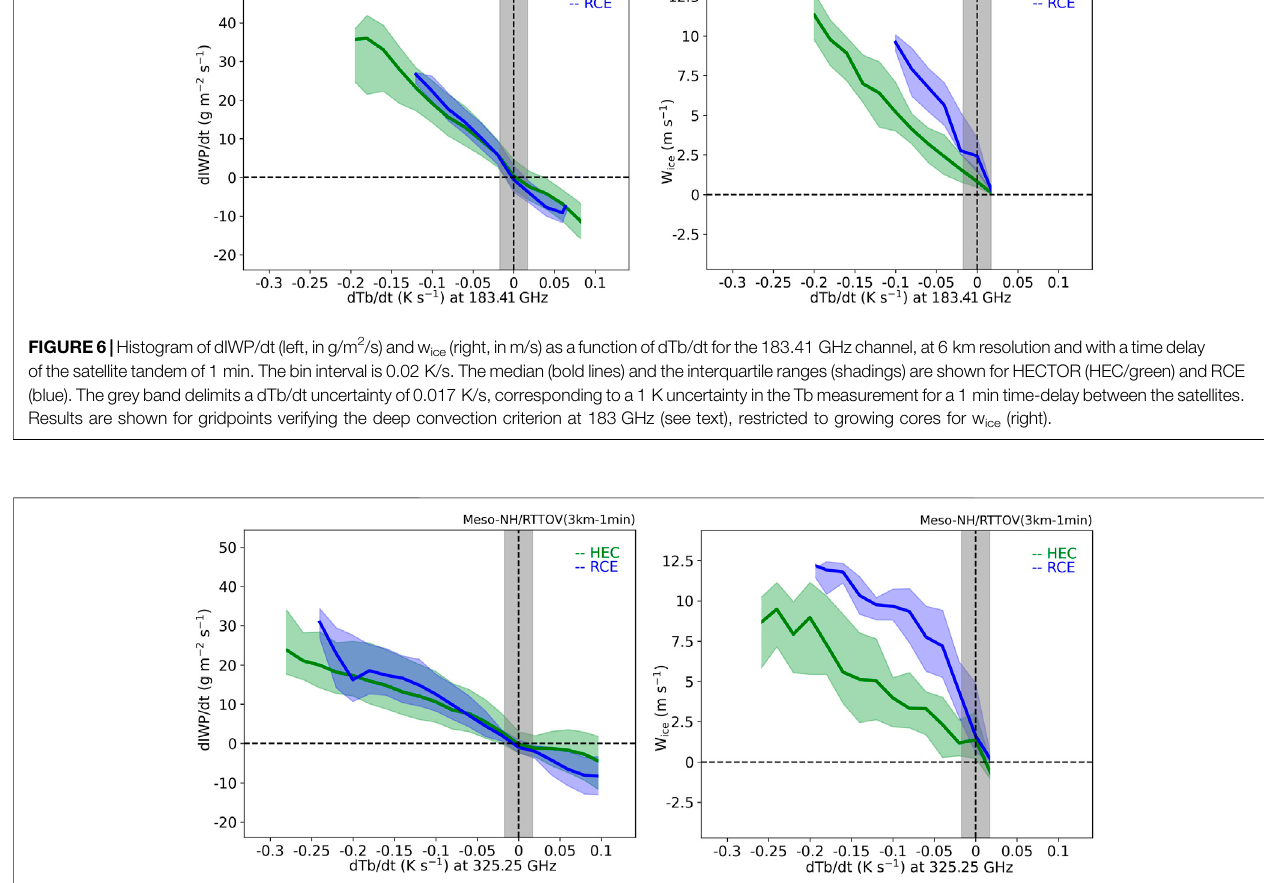
Frontiers in Remote Sensing |